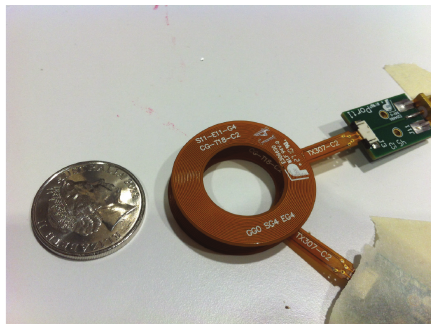
Figure 8: Setup for measurement of coupling coefficient.